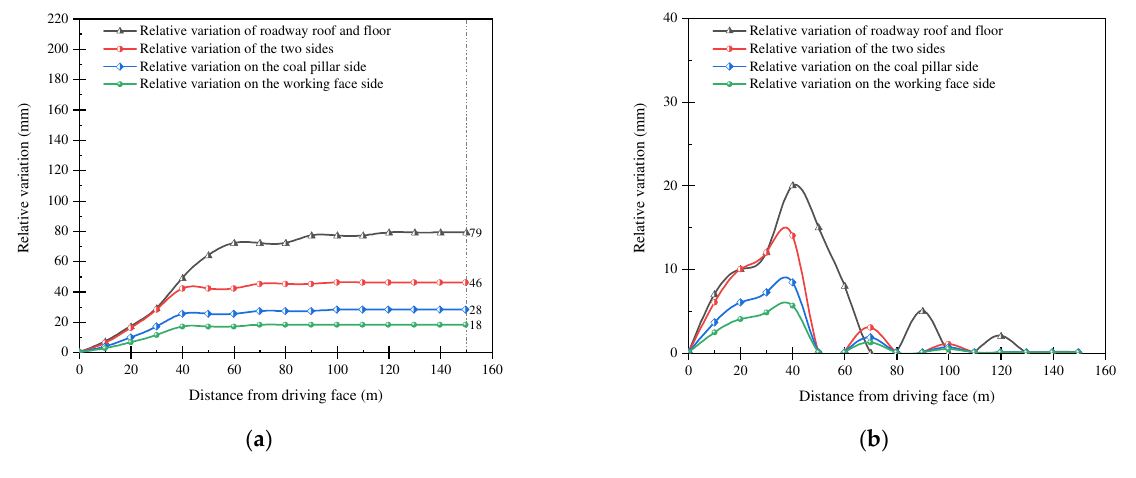
Figure 19. Spatial and temporal evolution characteristics of the deformation and damage of the surrounding rock at station III: ( a ) displacement of the roadway surface; ( b ) deformation speed of the roadway